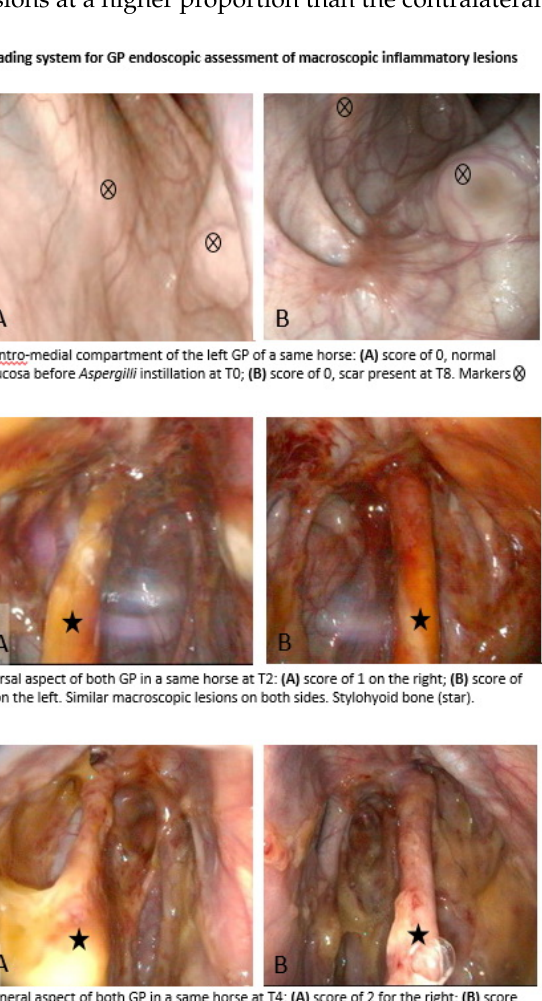
Figure 2. Endoscopic grading system of macroscopic inflammatory lesions present in the GP.